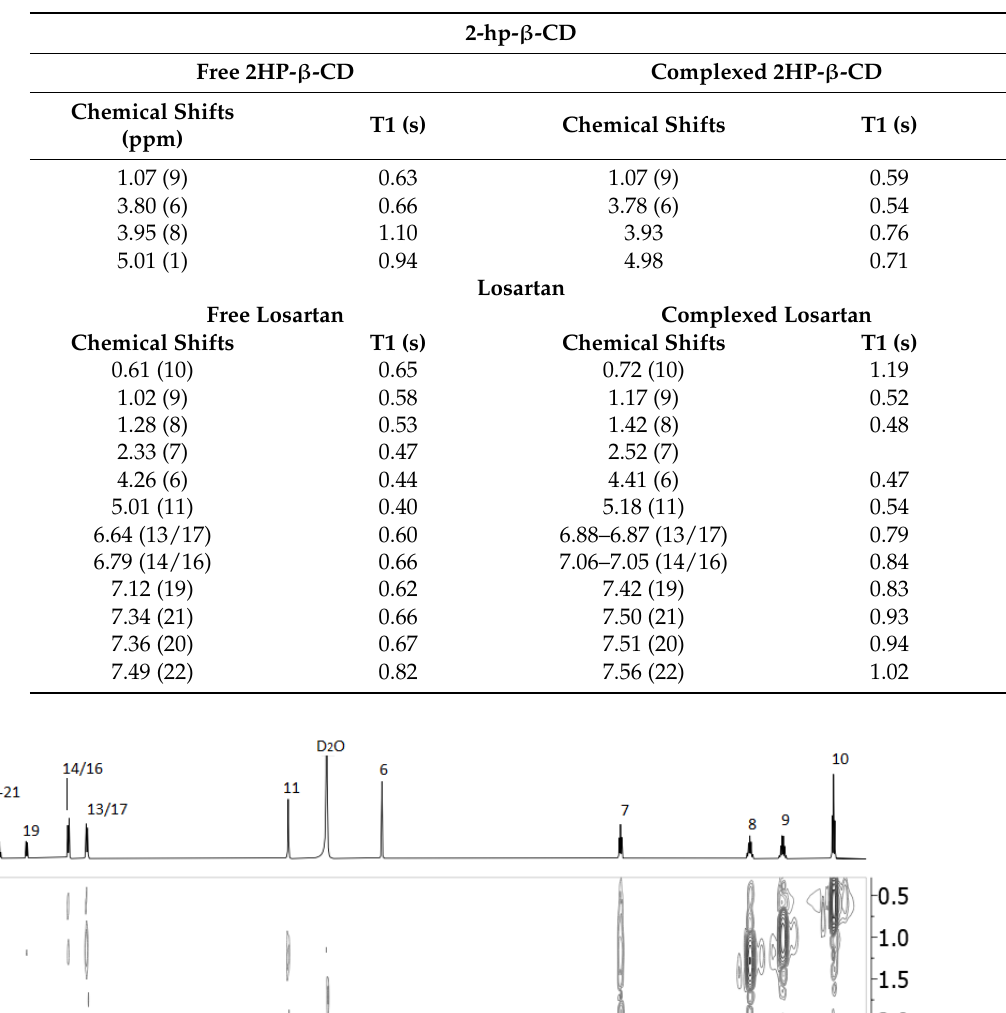
Table 4. In this table the T1 values of protons of the three samples under study are shown; thus, losartan, 2HP- β -CD and the complex of losartan:2HP- β -CD.